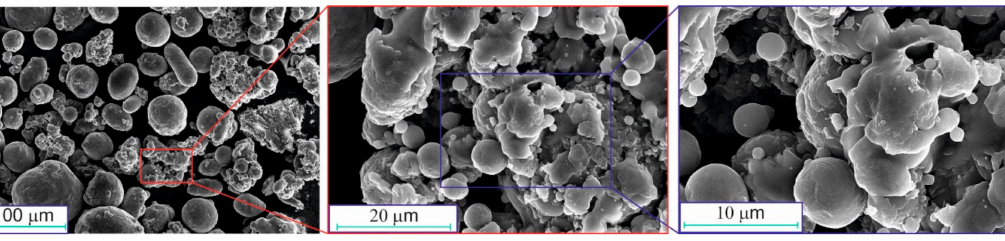
Figure 3. SEM images of the initial aluminum